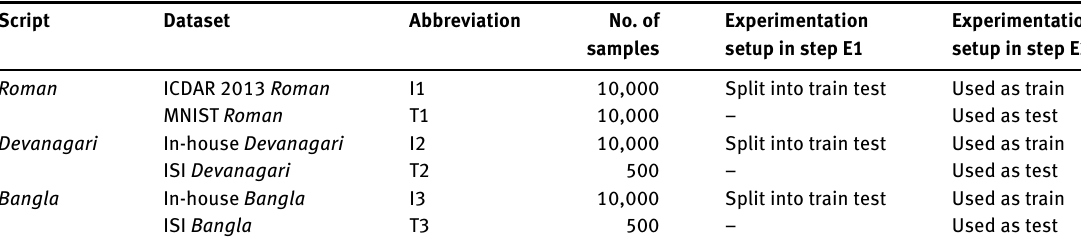
Figure 2: Sample Numeral Images Written in (A) Bangla , (B) Devanagari , and (C) Roman Scripts. Table 1: Outline of Datasets Used for Experiments E1 and